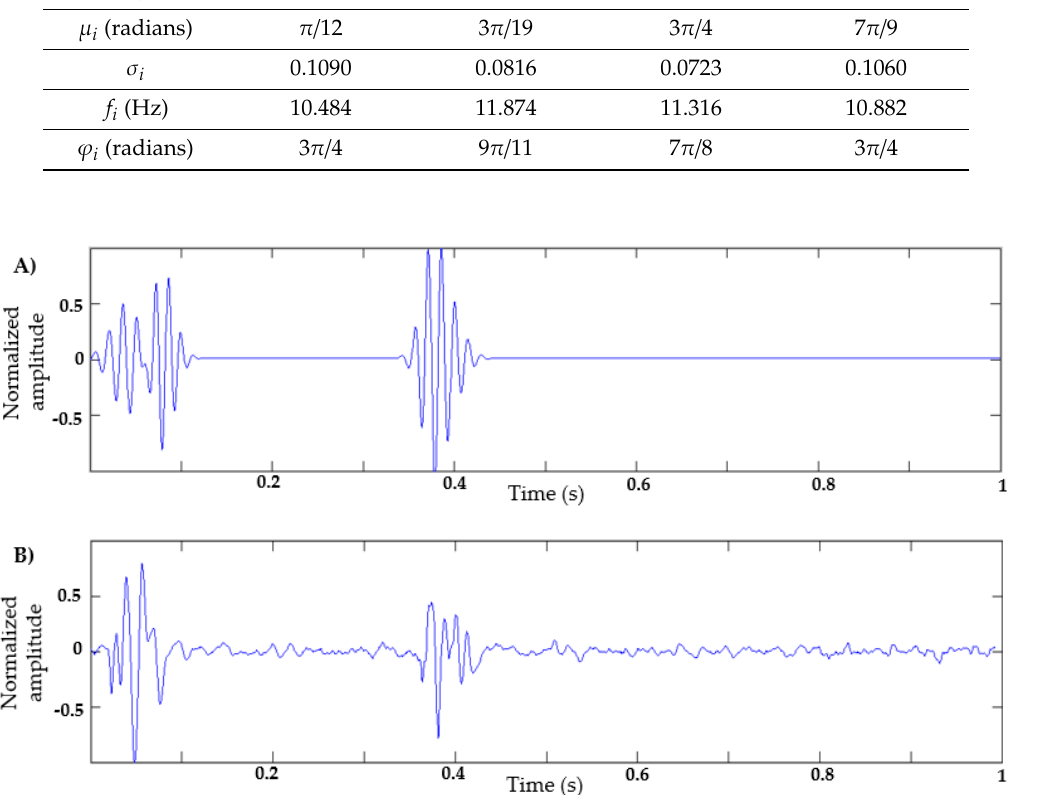
Table 3. Parameters used in [21] to generate normal heart sounds.